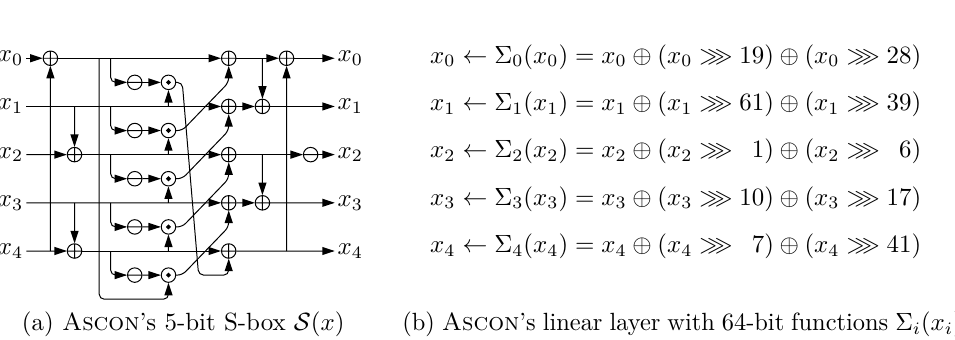
Figure 2: Ascon ’s substitution layer and linear diffusion